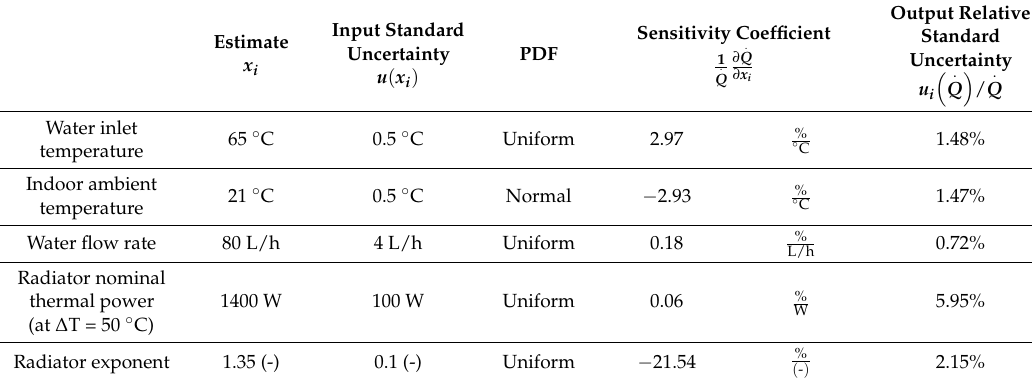
Table 2. Results of the sensitivity analysis and example of uncertainty budget for the proposed heat cost allocation